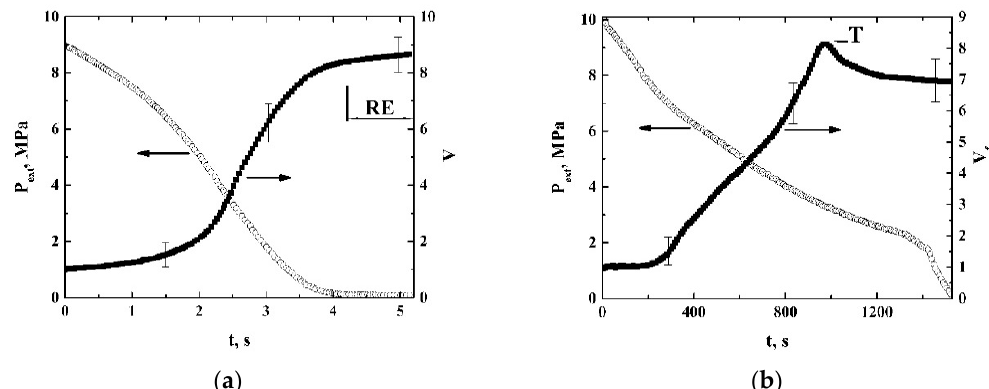
( a ) ( b ) P t (open circles) and       0 V t V t V   (filled Figure 3. Typical experimental dependencies   ext f f f squares); ( a )—quasi-adiabatic expansion; T  309.15 K; ( b )—quasi-isothermal expansion; T  313.15 K; “RE” is the residual expansion stage; “T” is the expansion-to-shrinkage transition. Selectively shown error bars correspond to the confidence level of 0.9.